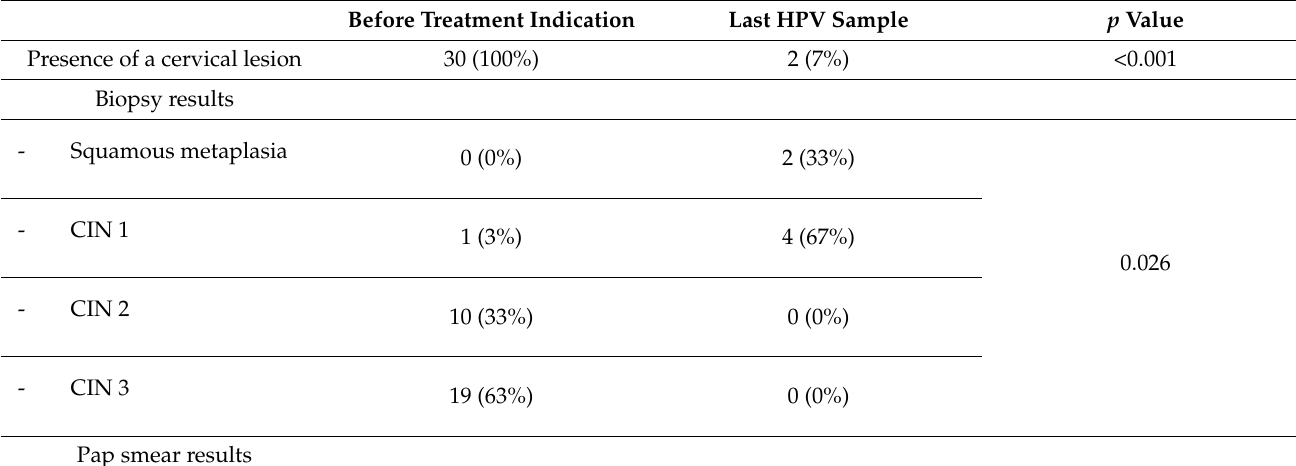
Table A1. Prevalence of cervical lesions, biopsy results, and Pap smear results before treatment and by the end of the follow-up among women who received